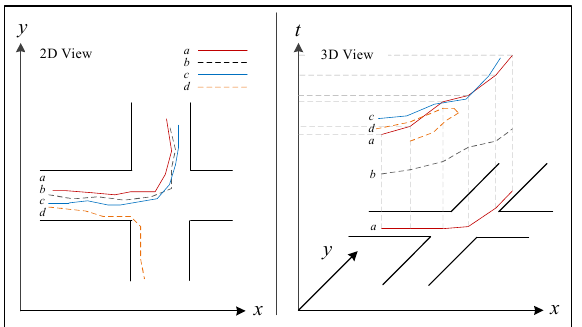
Figure 3. Trajectory clustering results visualization in traditional 2D view and proposed 3D view